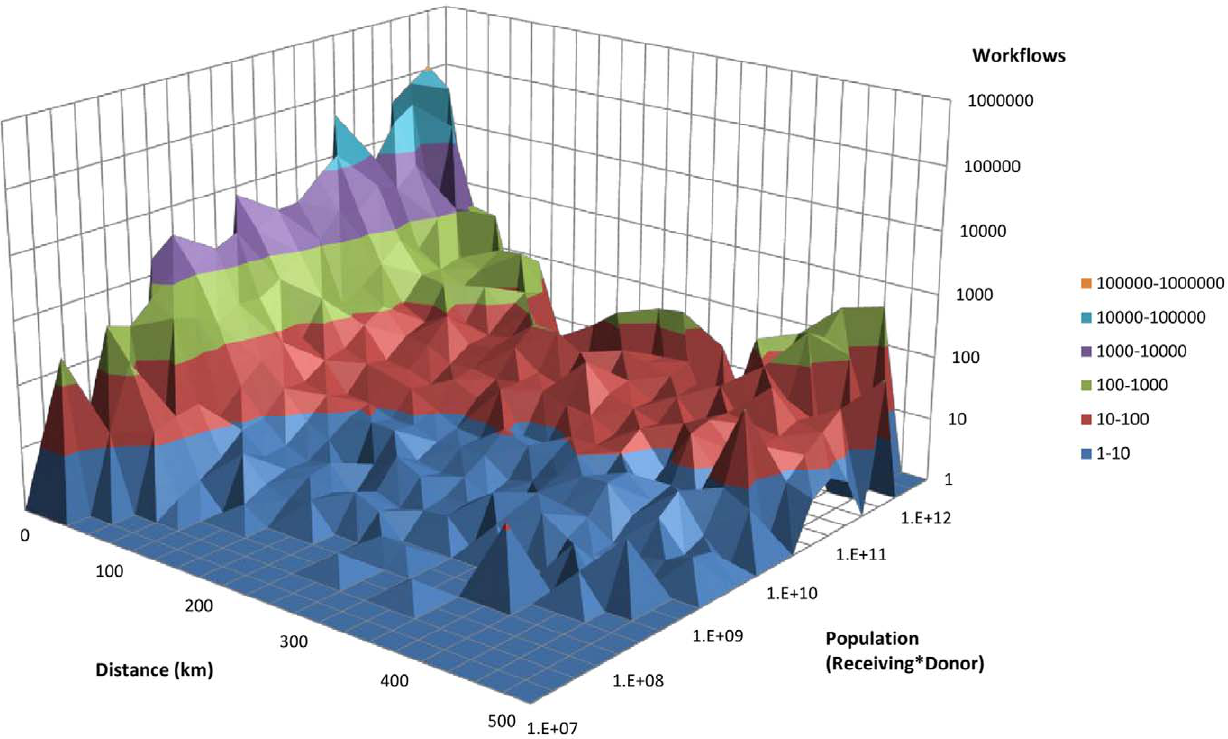
Figure 5. Association of workflows, population and distance. (y-axis and z-axis log10 scale). The relationship between workflows (z-axis), population size (y-axis) and distance (x-axis).